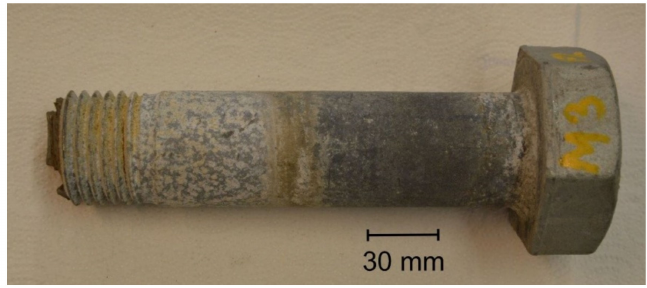
Figure 6. General view of the S2 bolt’s fracture formed in the threaded part.